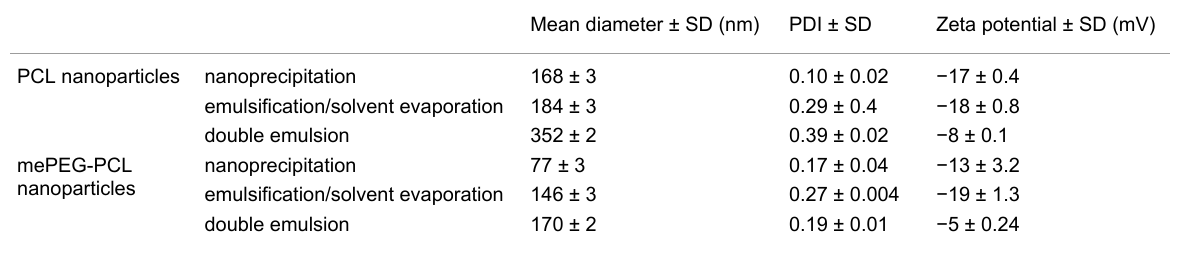
Table 1: The effect of different preparation methods on physicochemical properties of blank PCL and mePEG-PCL nanoparticles ( n = 3 ±